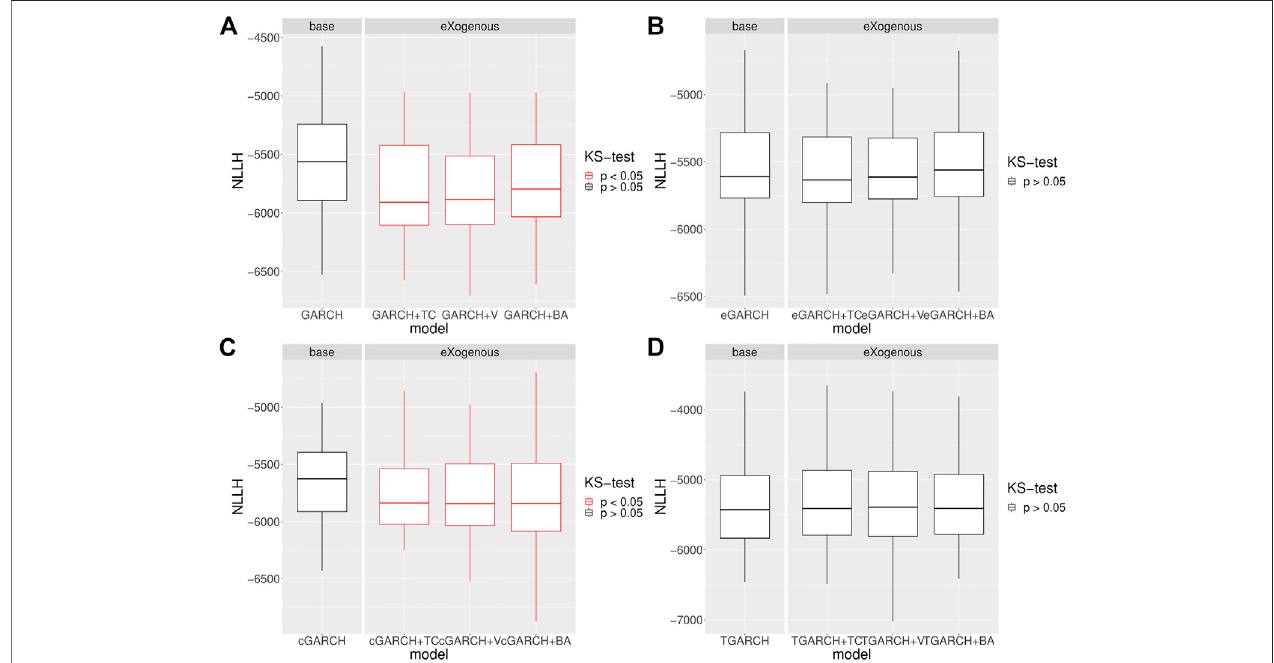
FIGURE7| Bootstraprobustnesscheck over N (cid:1) 100splitting points with T (cid:1) 1,000 training points and T (cid:1) 1,000test sizeforGARCH and GARCHX models. The price is de fi ned as volume-weighted. The nonparametric Kolmogorov – Smirnov test of the equality of the NLLH out-of-sample distributions between the GARCH and GARCHX models is done. (A) KS test implies a signi fi cant difference for both external signals for the GARCH model. (B) KS test implies no signi fi cant difference for external signals for the eGARCH model. (C) KS test implies no signi fi cant difference for both external signals for the cGARCH model. (D) KS test implies no signi fi cant difference for external signals for the TGARCH